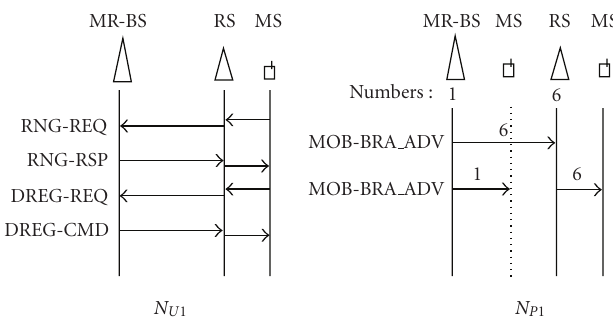
Figure 9: Signaling flow and signaling cost N U